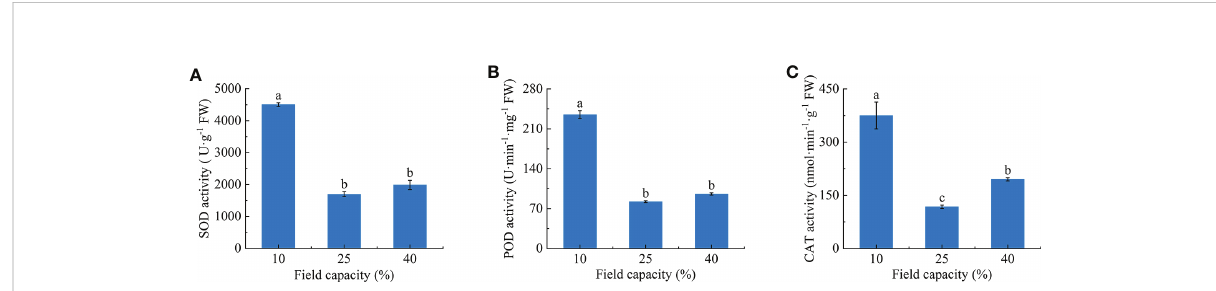
FIGURE 5 Effects of different soil moisture on superoxide dismutase (SOD) (A) , peroxidase (POD) (B) and catalase (CAT) (C) activities of K hirsuta . Results were analyzed by one-way ANOVA and tested for signi fi cance of difference by Duncan multiple-range method. Each value represents the mean ± standard error. Each experiment was repeated four times. Different letters indicate that the differences between treatments were signi fi cant ( P <